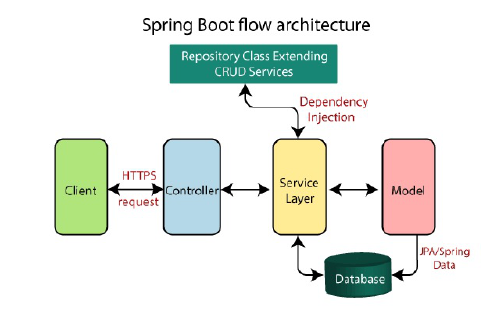
Fig. 4 Spring frame structure.